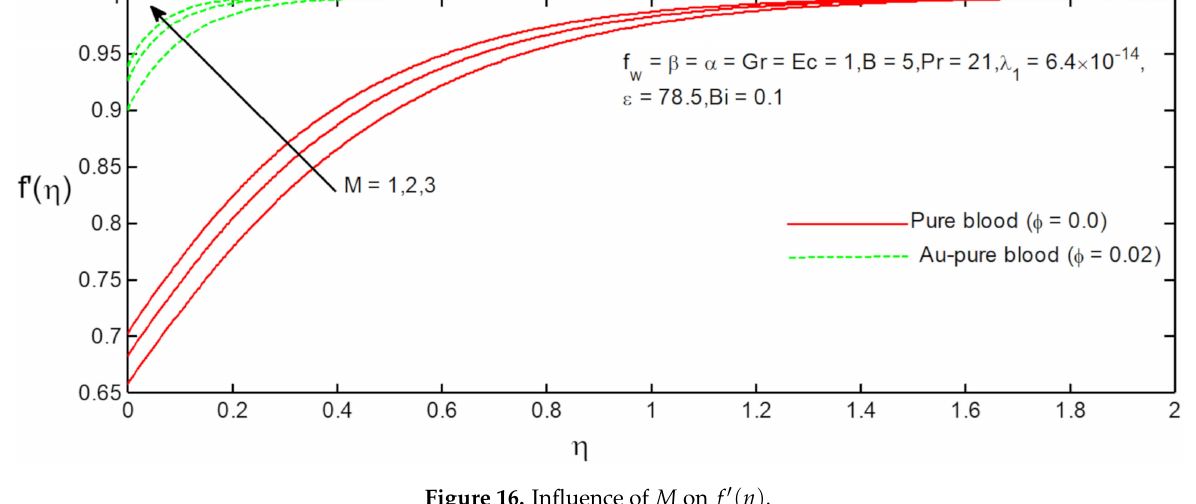
Figure 16. Influence of M on f (cid:48) ( η ) .